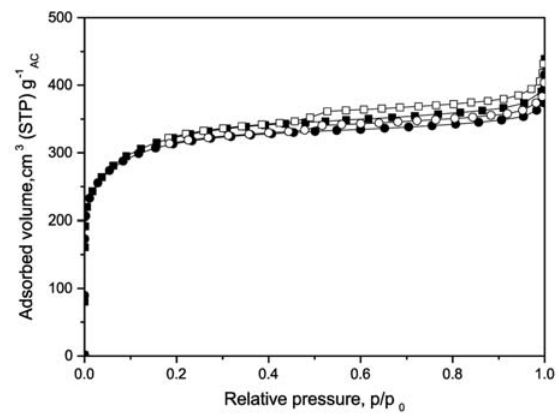
Figure 1. Adsorption isotherms of nitrogen obtained at –196 °C on the parent AC ( (cid:2) – adsorption, (cid:3) – desorption) and the CsOH loa- ded ( (cid:4) – adsorption, (cid:5) – desorption) samples. Only the parent and the CsOH loaded samples are shown in figure, because all impreg- nated samples give nearly the same isotherms.